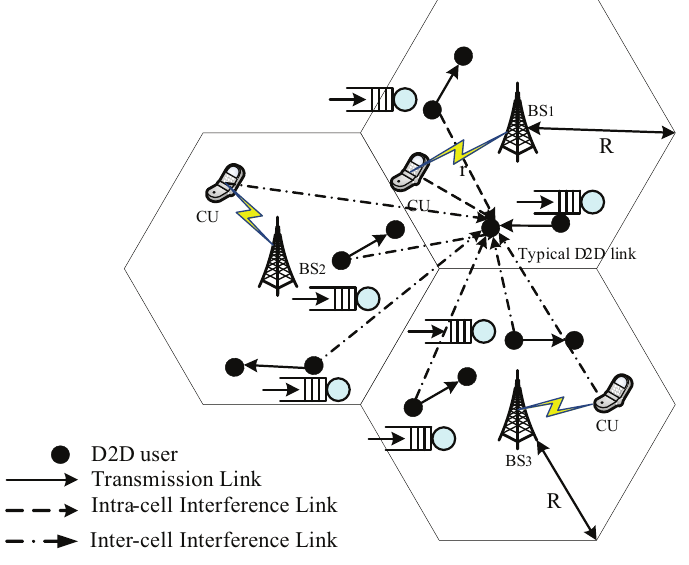
Figure 1. A hybrid network consisting of both cellular and D2D